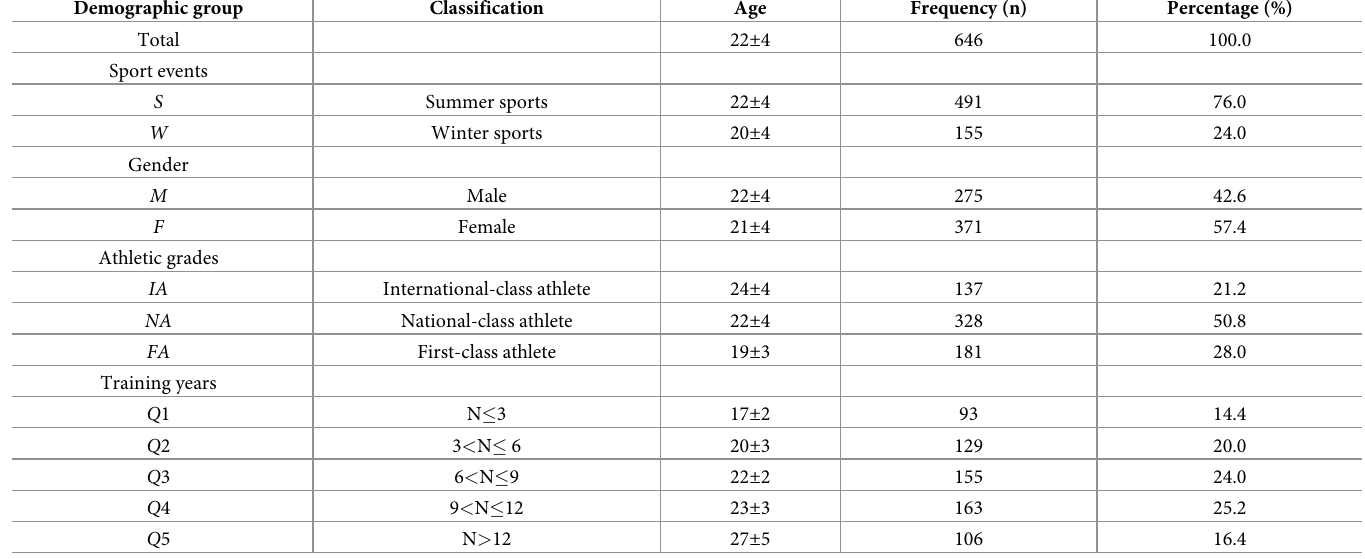
Table 1. Demographic characteristics of